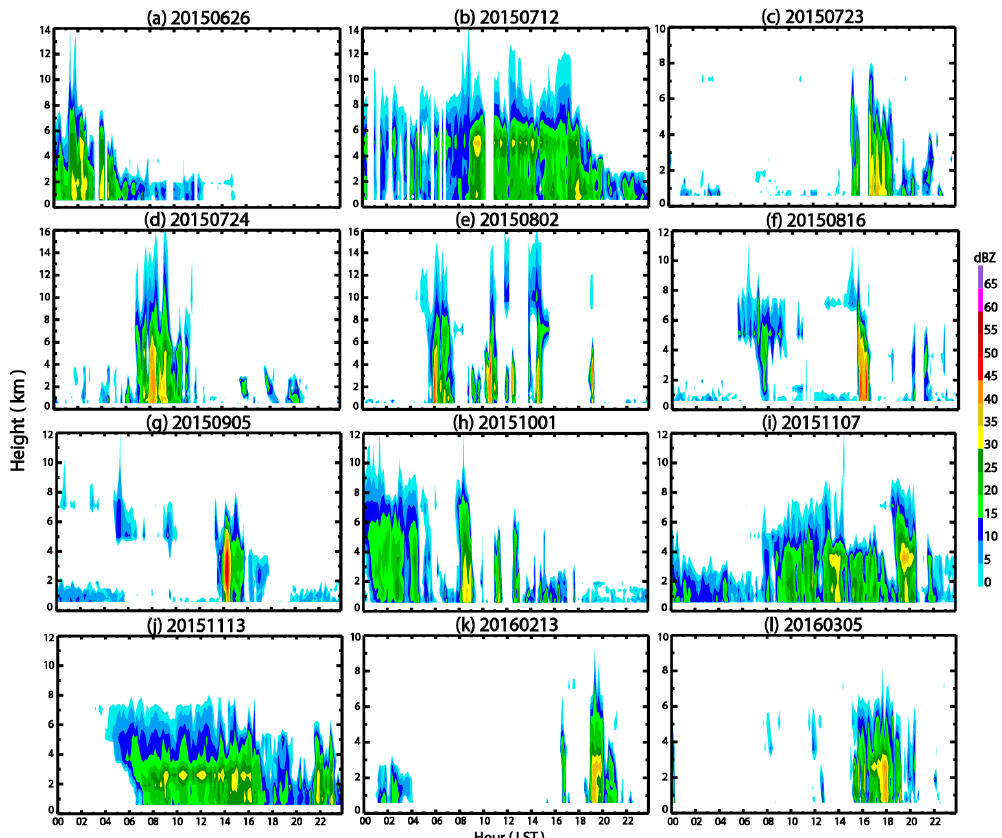
Figure 3. Time-height cross-sections of reflectivity at 10-min resolution measured by the